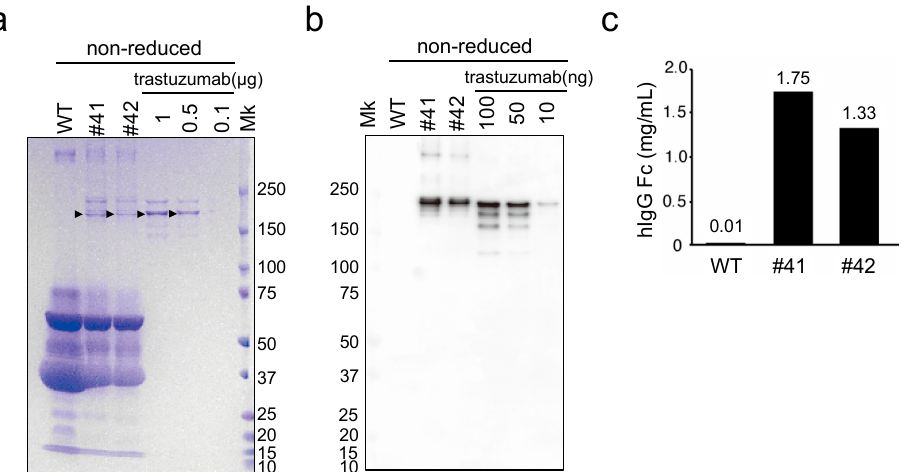
Figure 2. Evaluation of mAbs deposited in KI egg whites using SDS-PAGE and immunoblotting, under nonreducing conditions. ( a ) SDS-PAGE of WT and mAb KI (#41 and #42) egg whites, and recombinant trastuzumab, stained with Coomassie Brilliant Blue. The egg white samples (20-fold diluted) and trastuzumab (0.1–1 µ g) were loaded as indicated at the top of the lanes. Arrowheads indicate the major bands estimated to be fully assembled mAbs. Mk: protein standard marker. ( b ) Immunoblotting with the anti-human immunoglobulin G (hIgG) Fc antibody against WT, mAb KI egg whites, and recombinant trastuzumab. The egg white samples (200-fold diluted) and trastuzumab (10–100 ng) were loaded as indicated. ( c ) Concentration of hIgG estimated using immunoblotting. Each immunoreactive signal was quantified using ImageJ, and the relative concentrations of hIgG in egg whites were estimated using trastuzumab as a standard.